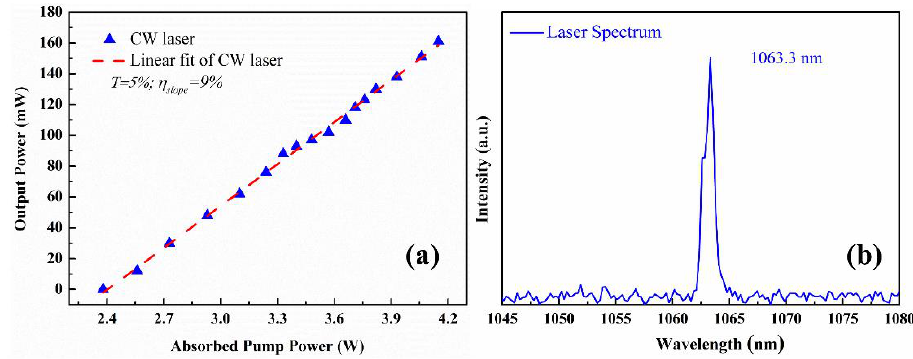
Figure 8. ( a ) Pump power versus average output power and ( b ) laser spectra [33].